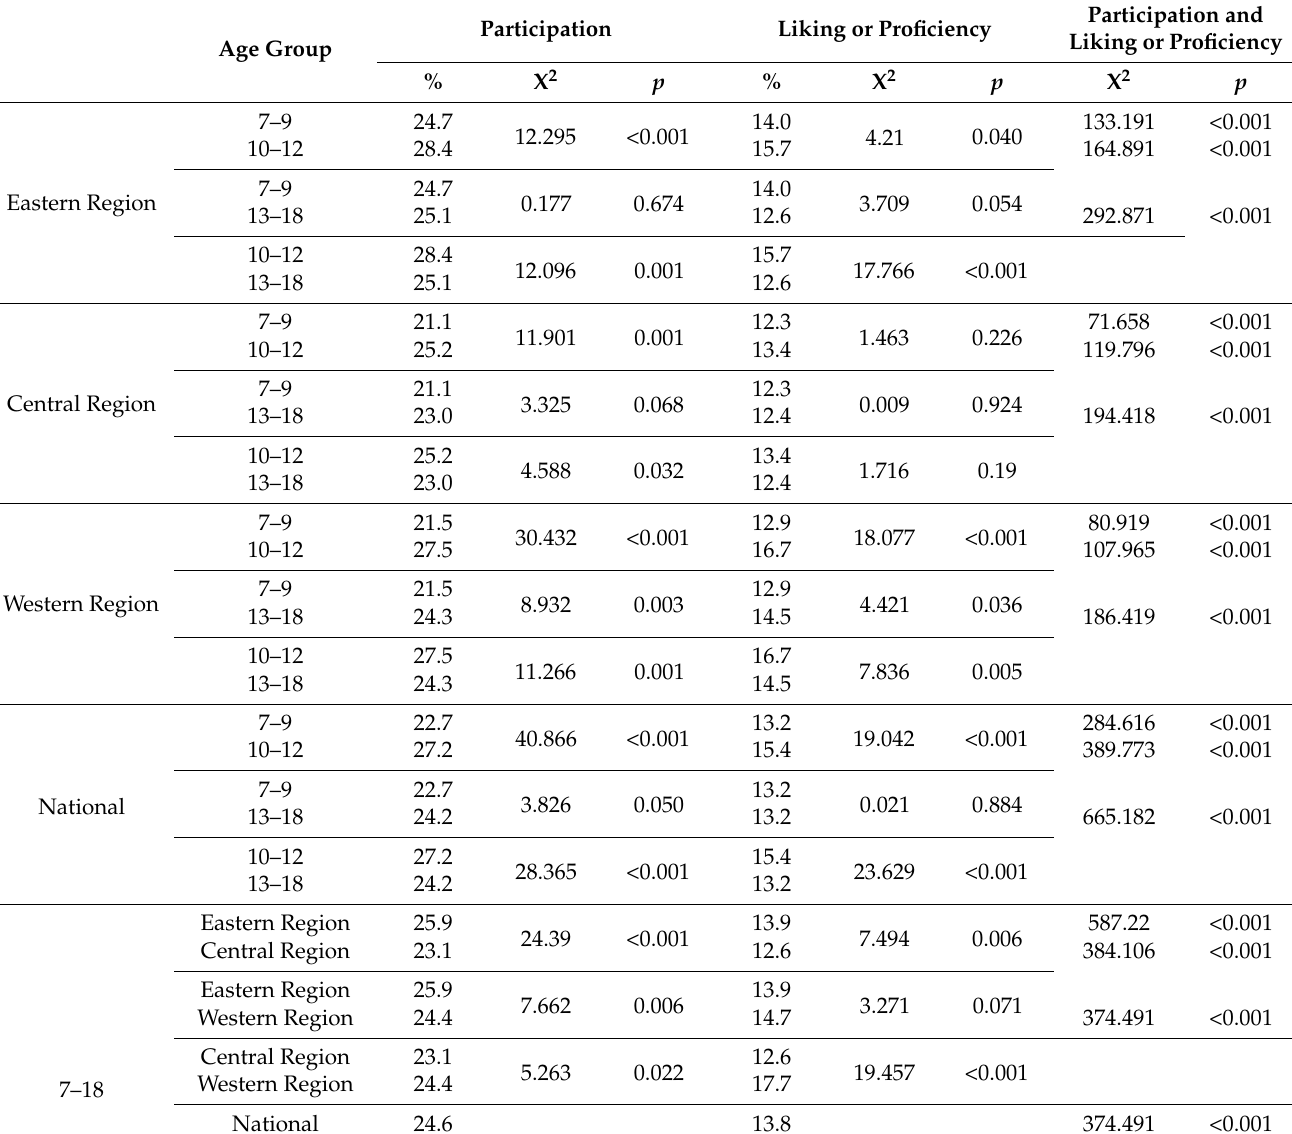
Table 4 for more details. Table 4. Percentage of “soccer population” by age group and three major